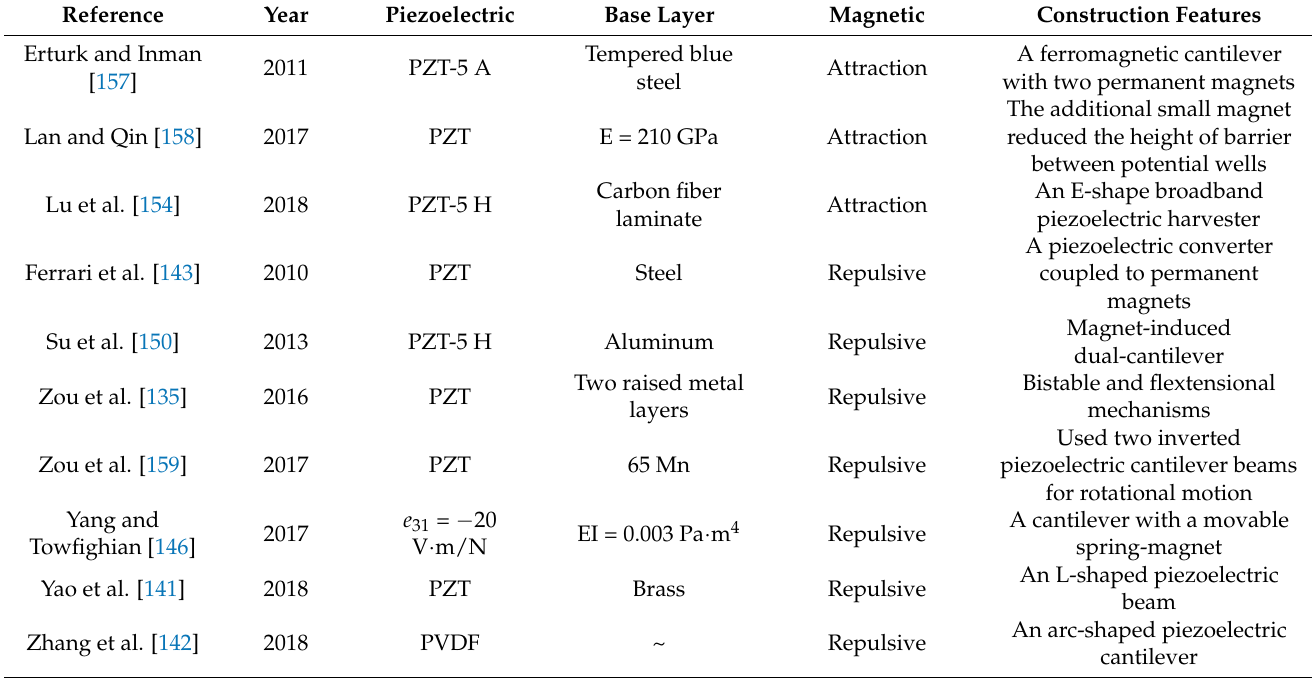
Table 2. Characteristics of some existing bistable-type piezoelectric